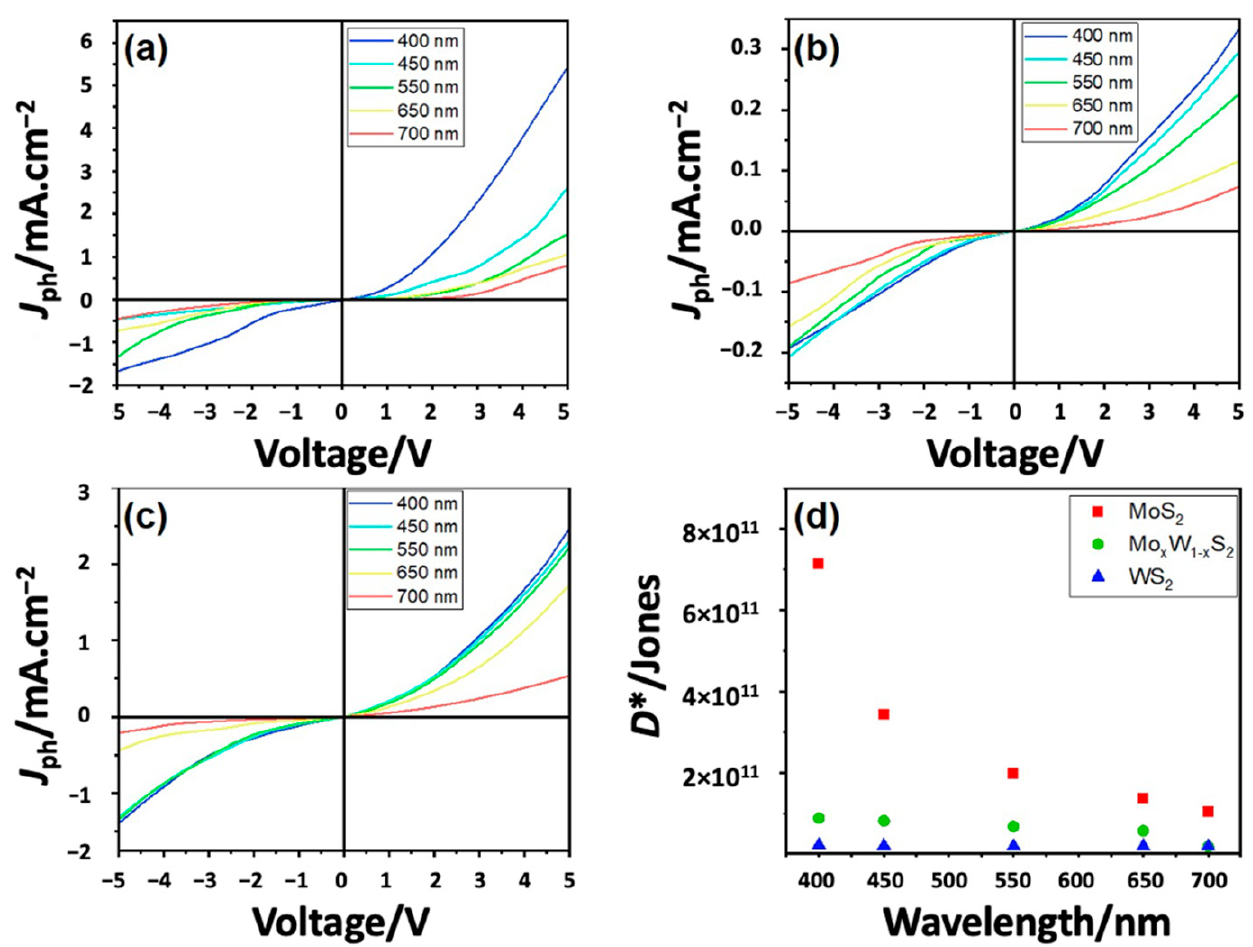
Figure 11. Photocurrent density J ph measured for ( a ) MoS 2 , ( b ) WS 2 , ( c ) Mo x W 1-x S 2 , and ( d ) their respective relative detectivity under 400–700 nm wavelength excitations.